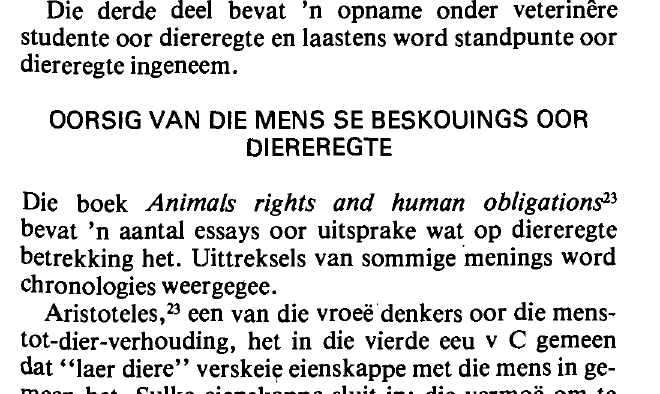
OORSIG VAN DIE MENS SE BESKOUINGS OOR